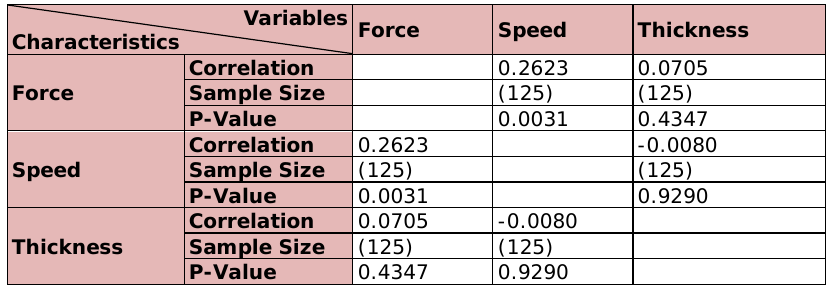
Table 7. “Correlation coefficients of force, speed, and